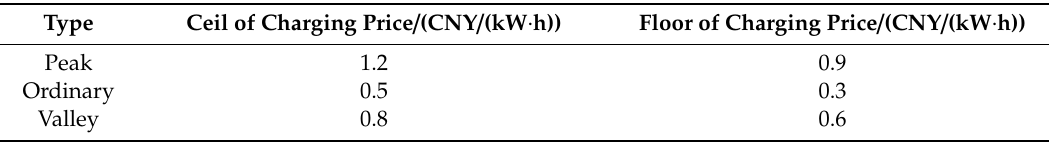
Table 3. Optimization range of charging electricity price.